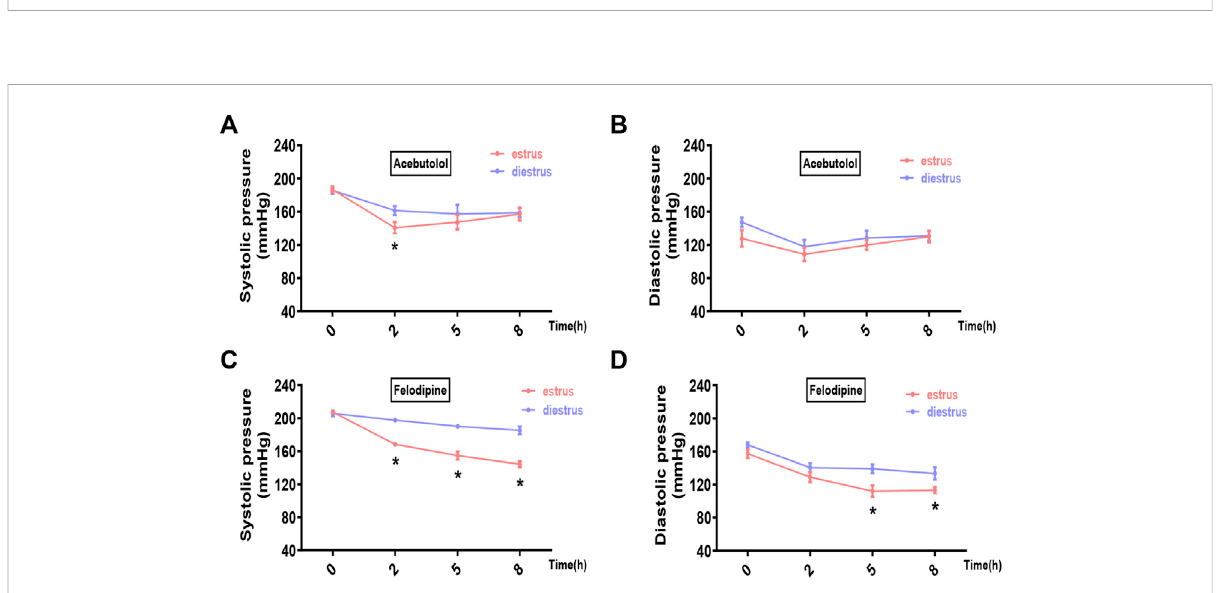
FIGURE 6 Acebutolol and felodipine exert stronger hypotensive effects on hypertensive rats in estrus than in diestrus. Female SHR rats in estrus and diestrus were orally treated with acebutolol (50 mg/kg body weight) and felodipine (30 mg/kg body weight), respectively, and then blood pressure levelsweremonitoredinthefollowing8 h(0,2,5,8 h) (A) Systolicbloodpressureand (B) diastolicbloodpressurechangesafteracebutololtreatment (C) Systolic blood pressure and (D) diastolic blood pressure changes after felodipine treatment. p -values were determined by two-way ANOVA followed by Bonferroni correction, the values ≤ 0.05 were considered statistically signi fi cant. N = 8, * p -value ≤